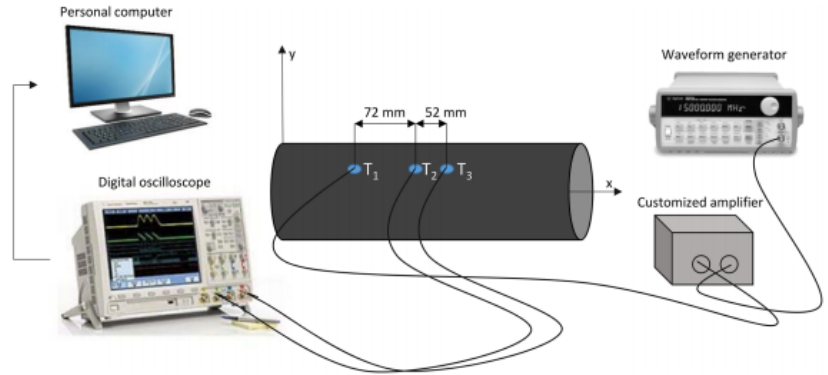
Figure 2. Schematization of the overall experimental setup adopted for wave propagation analysis